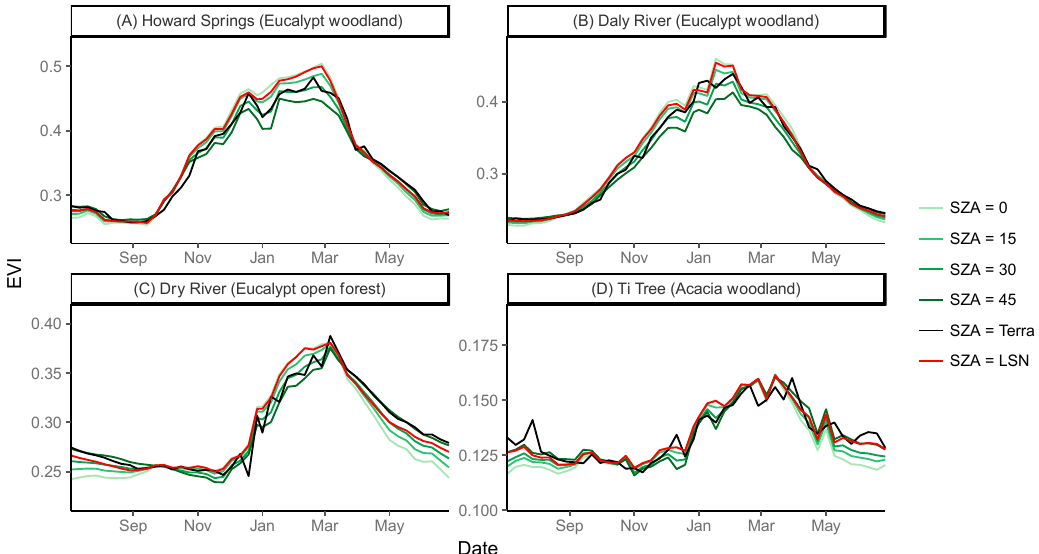
Figure 5. Mean seasonal profile of BRDF-corrected EVI from 2010 to 2018, including EVI SZA-Terra , EVI SZA-LSN, EVI SZA-0 , EVI SZA-15 , EVI SZA-30 and EVI SZA-45 at 4 NATT flux tower sites. All EVIs have been adjusted to the nadir view. The shaded area indicates the 95% confidence interval of the mean.